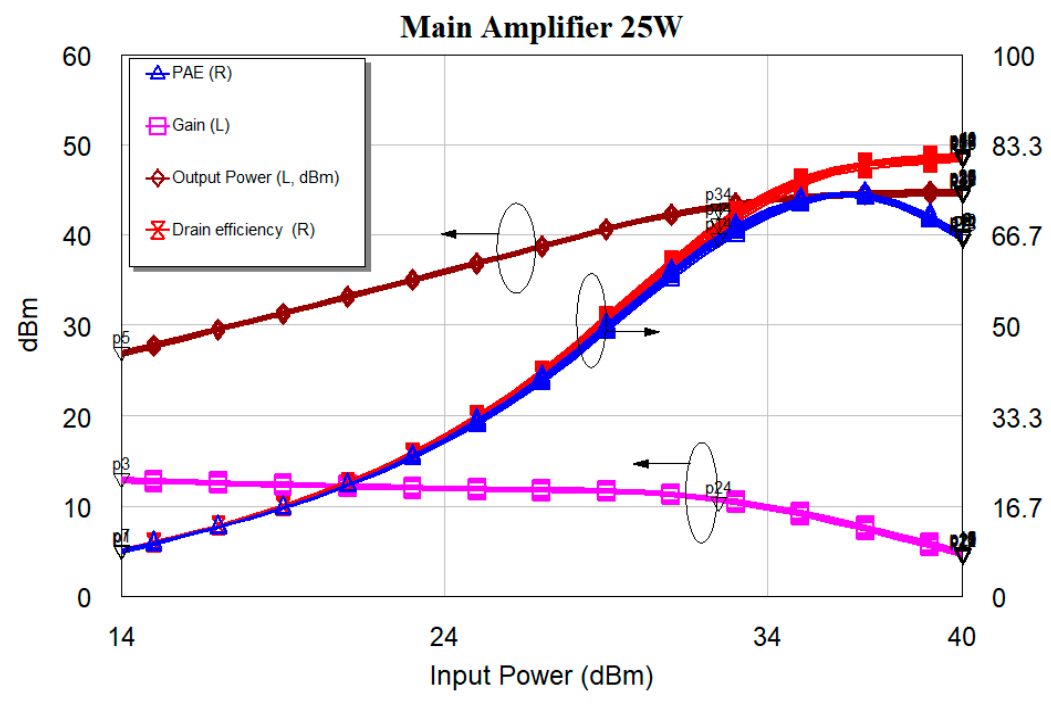
Figure 7. Main amplifier performance.